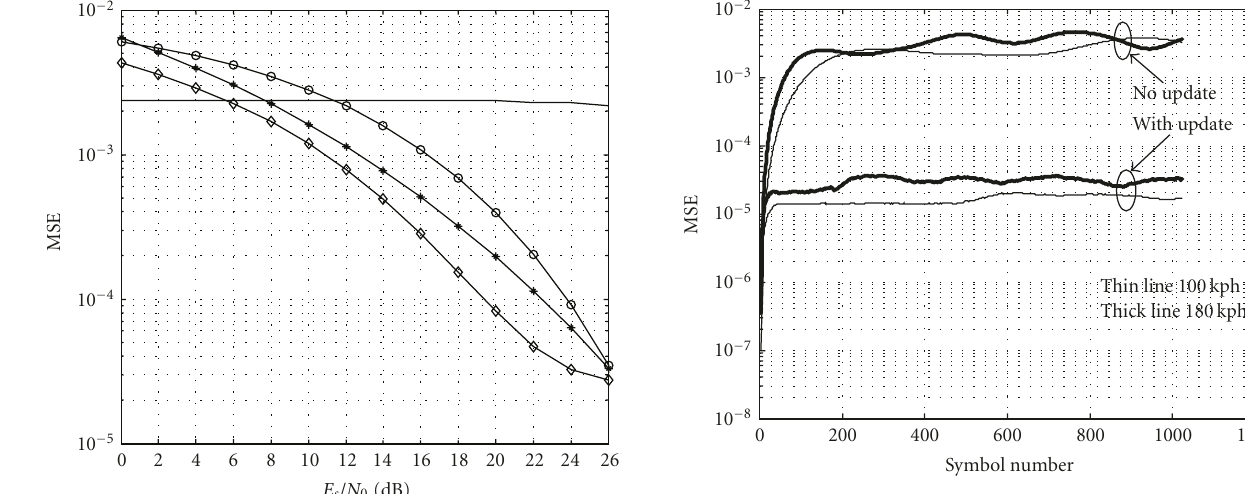
Figure 6: MSE of channel estimation versus the number of symbols at 26 dB.